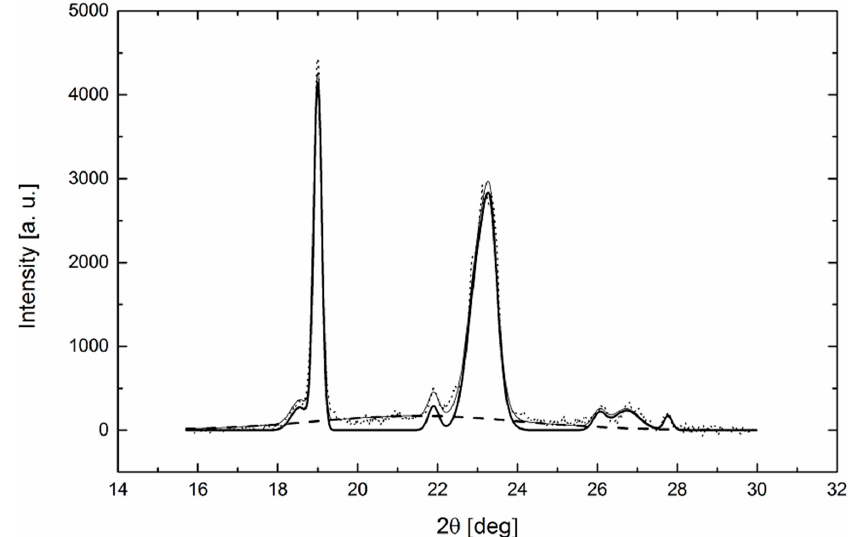
Figure 3. Diffractogram of nanofibrous PEO sample separated into individual crystalline peaks (solid thick line) and an amorphous halo (dashed line). The dotted line shows the experimental data and the solid thin line represents the amorphous and crystalline part fitted together.